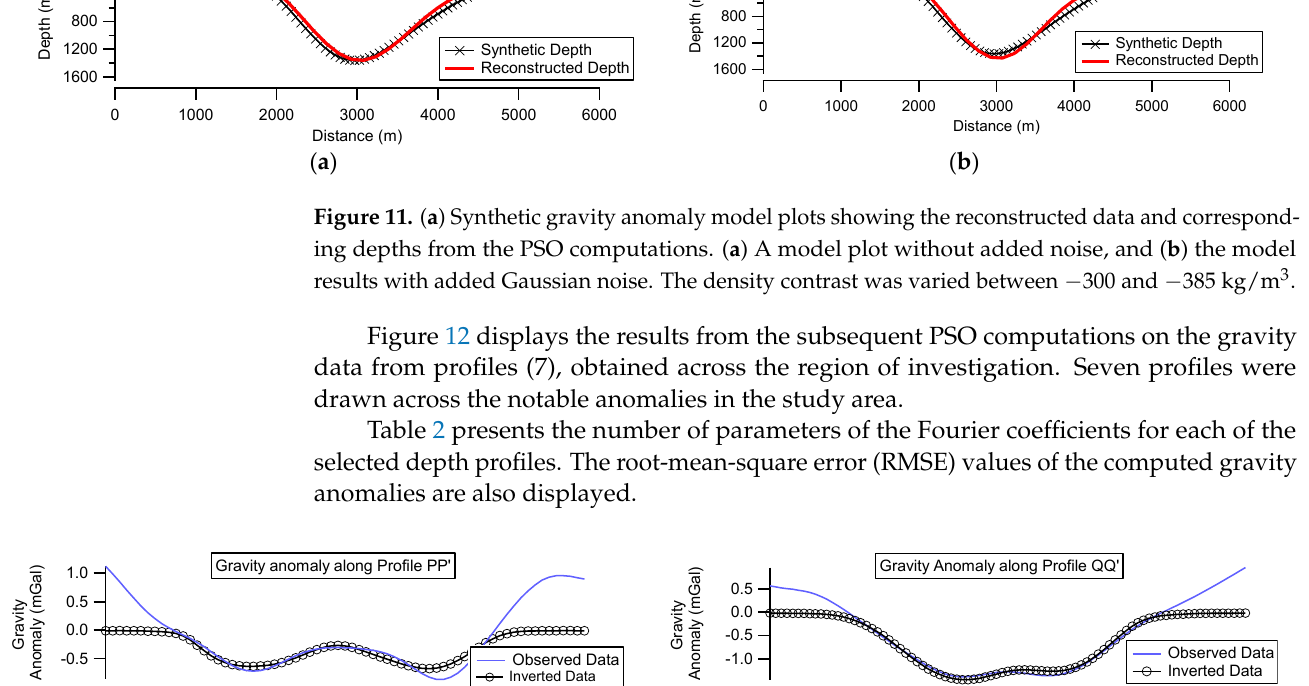
( b ) QQ’ density contrast (cid:4666) (cid:3398) 69– (cid:3398) 66(cid:4667) km (cid:2879) (cid:2871) .